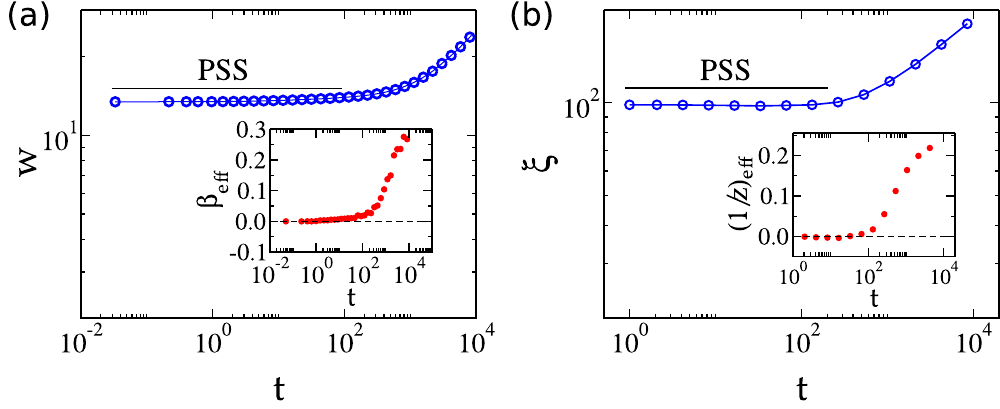
Figure 2. Temporal evolutions of ( a ) interface width w and ( b ) correlation length ξ for the 1D model. Insertions show the effective ( a ) growth β eff and ( b ) inverse dynamic 1/ z eff exponents as functions of time.